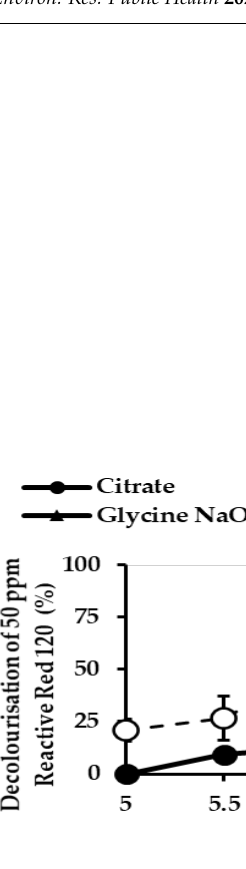
Figure 11. Effects of different pH buffers on the decolourisation of 50 ppm Reactive Red 120 by consortium JR3. Data represent mean ± SD, n = 3.